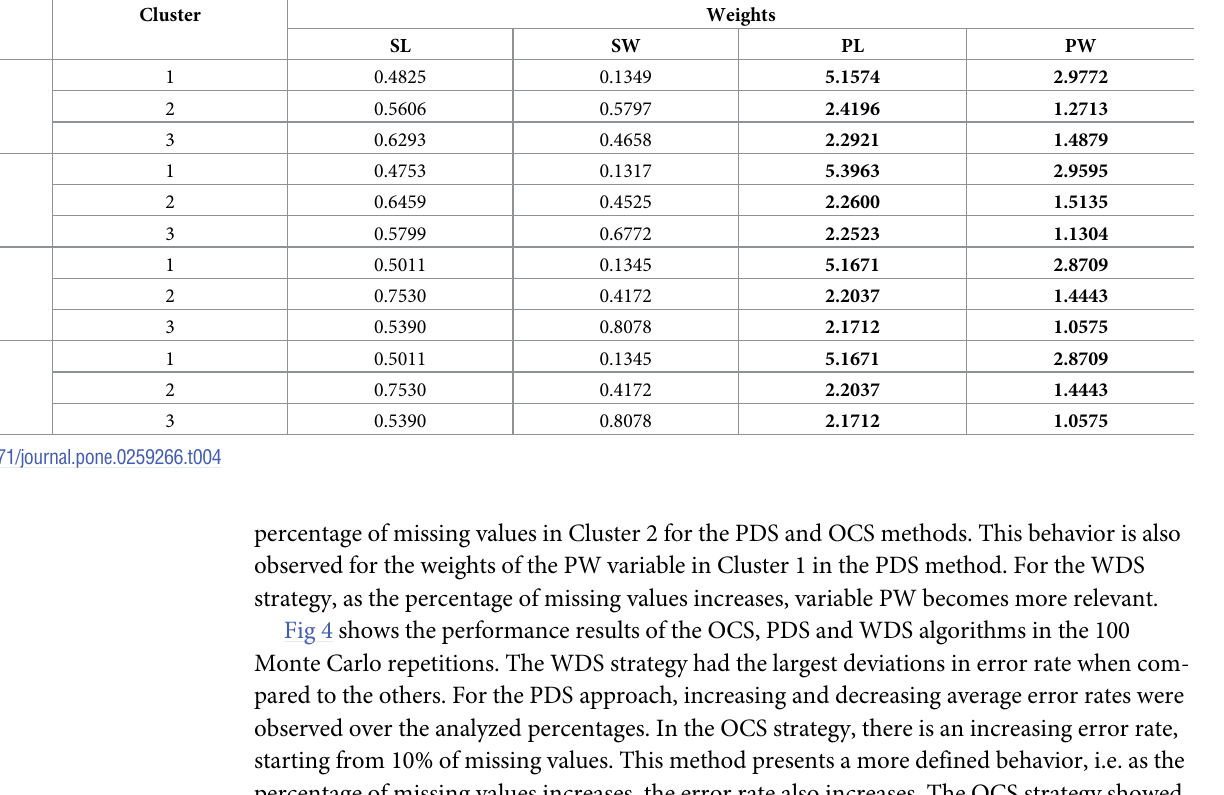
Table 4. Weights of the variables in each group adjusted by the VKFCM-K-LP algorithm with the PDS strategy under different percentages of missing values. % NA Cluster